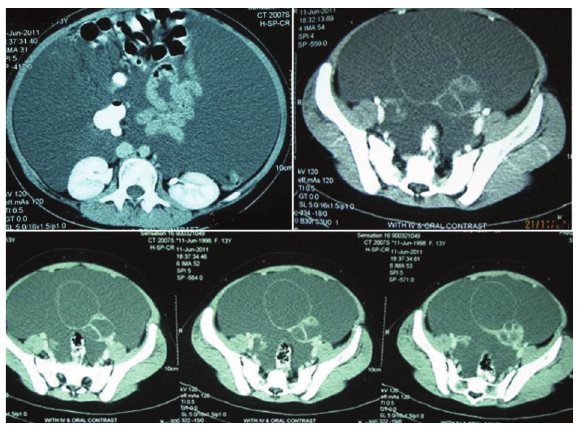
Figure 1: A 10×6 cm, multiseptated cystic mass is seen in the pelvis, originating from the left ovary with midline crossing associated with a large amount of ascites in the abdominopelvic cavity. No evidence of tumoral implants is seen on the peritoneal and mesenteric surfaces.